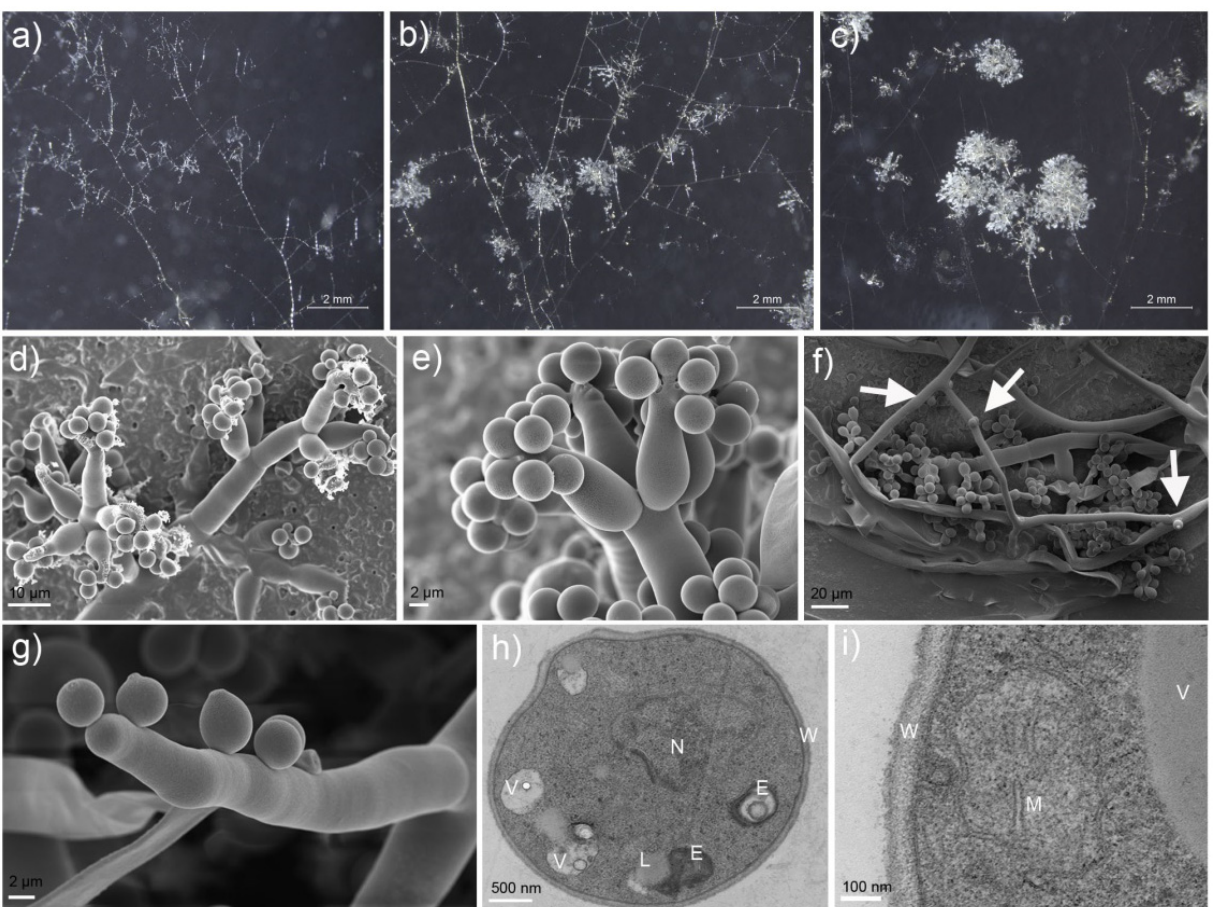
Figure 2. Formation and microscopic characteristics of Morchella sextelata mitospores. ( a ) Early state of mitotic spore development. ( b ) Mature abundant mitospore mats. ( c ) Close-up of mature mitospore mats appearance. ( d – g ) SEM images of mitospores: ( d , e ) mitospores growing from phialides supported by metulae, and ( f , g ) mitospores directly produced on hyphae surface (arrows). ( h , i ) TEM observation of mitospore inner structures: E—endoplasmic reticulum, L—lipid droplet, M—mitochondrion, N—nucleus, V—vacuole and W—cell